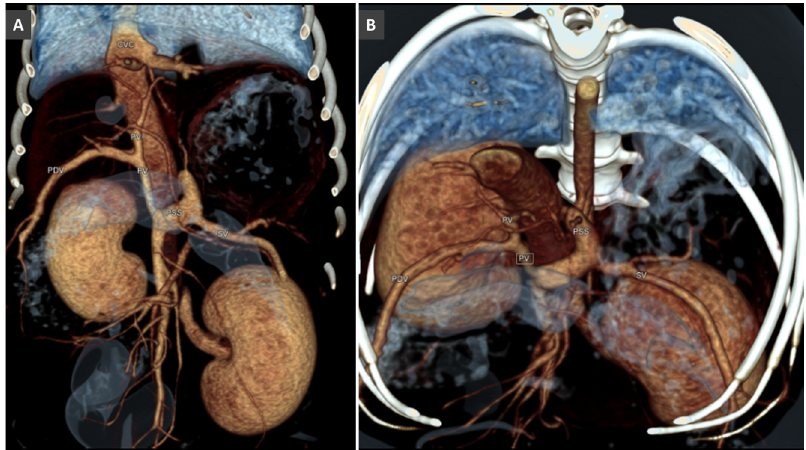
Figure 13. Extrahepatic PSS emanating from left gastric vein in a dog. ( A ). Volume rendered ventral view. ( B ). Frontal-oblique view, showing the site of insertion of the PSS in the pre-hepatic segment of the caudal vena cava.